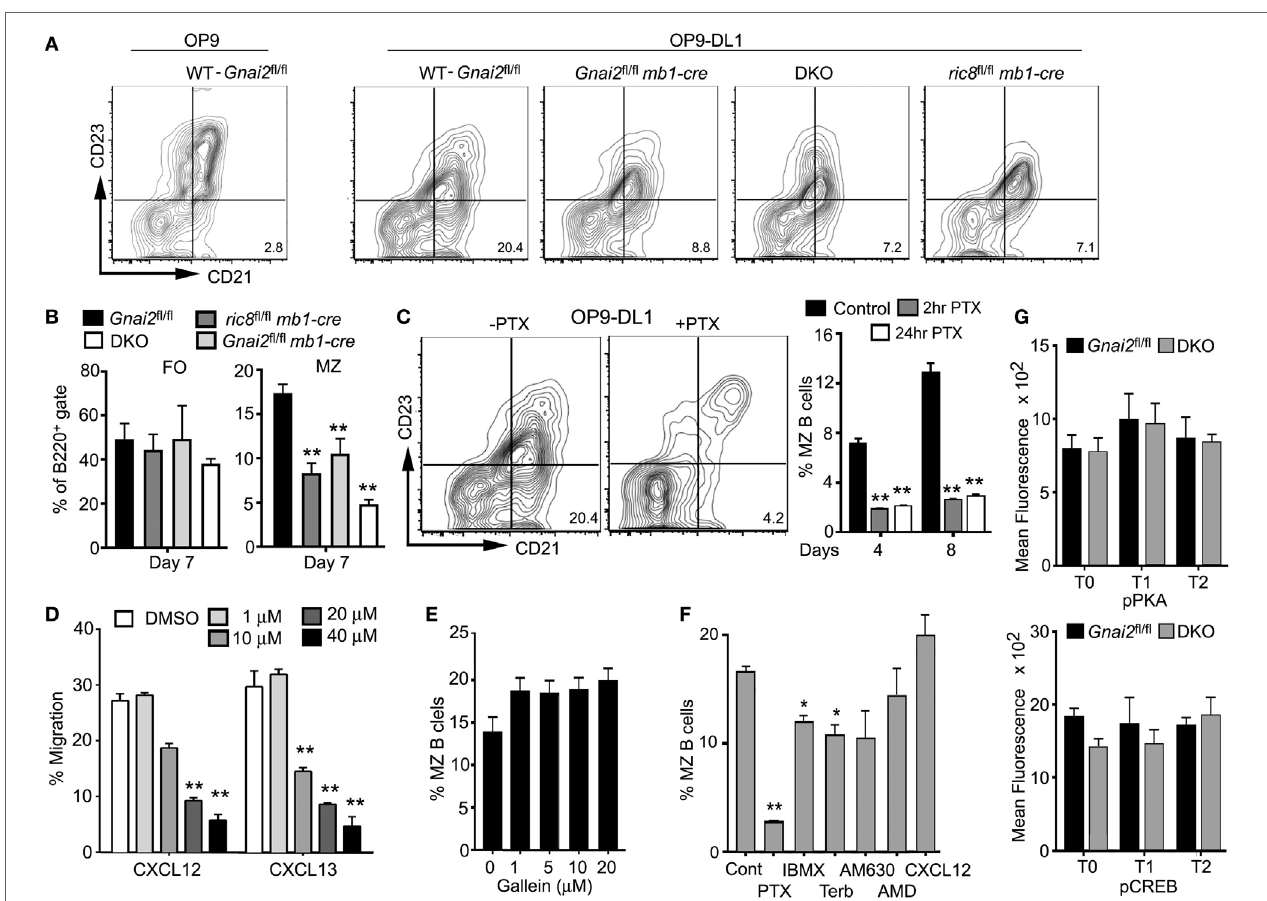
FigUre 3 | Even direct contact with Notch ligand expressing cells cannot rescue marginal zone (MZ) B cell development when G α i signaling is impaired. (a) Flow cytometry patterns of WT and G α i -deficient bone marrow-derived B cells plated on OP9 or OP9-Delta-like 1 (DL1) cells for 7 days in the presence of BAFF. Prior to their transfer to the stromal cell, WT and G α i -deficient bone marrow cells were cultured with IL-7 for 4 days. The % of MZ B cells is indicated in the lower right corner of each flow pattern. (B) Quantification of WT and G α i -deficient FO and MZ B cell development using OP9-DL1 system. Results from analyzing cells prepared from at least four mice of each genotype. Data are mean ± SEM (** p < 0.005). (c) MZ B cell development in OP9-DL1 system using WT cells treated with pertussis toxin (PTX), or not. PTX was added to the bone marrow cell culture for the terminal 2 or 24 h. After washing the cells were cultured on OP-9DL1 cells for 4 or 8 days. Shown are representative flow patterns and overall results from three experiments. (D) The G βγ inhibitor Gallein reduced B cell chemotaxis to chemokines. Splenic B cells were exposed to the indicated concentration of Gallein for 1 h prior to adding the cells to the upper chemotaxis chamber. An equal concentration of Gallein was present in the upper and lower chambers. The indicated concentration of CXCL12 was added to the lower chamber. Results are mean of three determinations for each concentration. Representative of one of three experiments performed. (e) Gallein does not inhibit the recovery of MZ B cells in OP9-DL 1 cultures. WT B cells were treated with the indicated concentration of Gallein, or not. The same concentration of Gallein was added to the culture every other day. Results from one experiment performed in duplicate. The experiment was repeated three times with comparable results. Data are mean ± SEM. (F) MZ B cell development in OP9-DL1 cultures is reduced by raising intracellular cyclic adenosine monophosphate (cAMP) levels. Bone marrow-derived B cell progenitors were plated on OP9-DL1 cells in the presence of IBMX (1 µm), terbutaline (10 nM), AM630 (1 µm), AMD3100 (1 µg/ml), or CXCL12 (1 mg/ml). The same concentration of each of the compounds was added on days 2, 4, and 6 except for PTX, which was only used to pretreat the cells prior to the OP9-DL1 culture. Results from 1 experiment performed in duplicate. The experiment was repeated three times with comparable results. Data are mean ± SEM (** p < 0.005, * p < 0.05). (g) No evidence